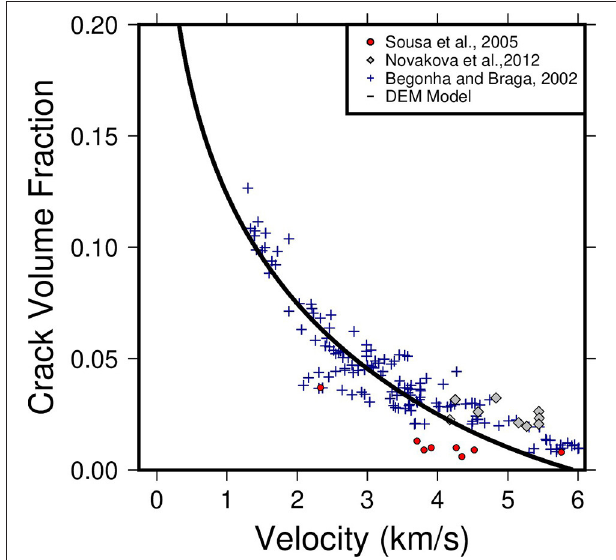
FIGURE 4 | Observed (symbols) and modeled (solid line) porosity and velocity relationships for weathered and fractured granites ( Begonha and Braga, 2002; Sousa et al., 2005; Novakova et al., 2012). In this case a small amount of porosity, or crack volume fracture, can significantly reduce the P-wave velocity. The modeled porosity follows the differential effective medium model and mineralogy described by Flinchum et al. (2018a). The equations, parameters, and minerology used to calculate the model are provided in the Supplementary Materials (Section